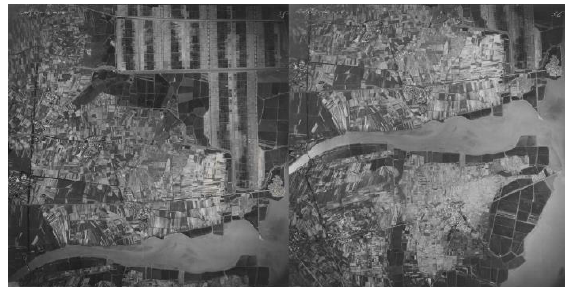
Figure 10. Image pairs of testing RANSAC.